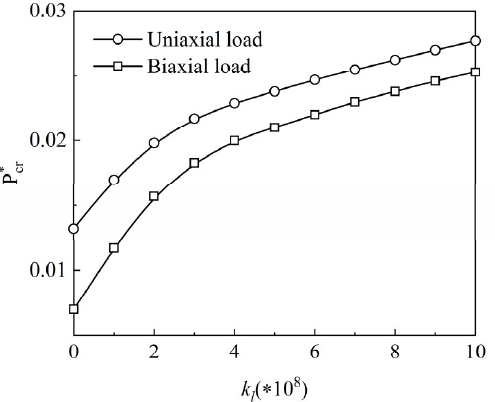
Figure 13. Variation of dimensionless critical buckling load along the elastic coefficient of the Winkler elastic foundation for an SSSS FG-GRP plate.